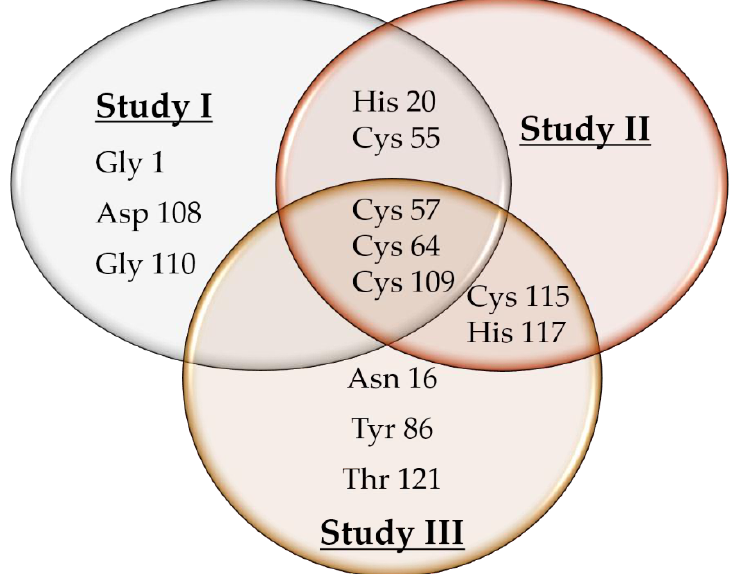
Figure 7. Venn diagram of the active site analysis of viral proteases. Study I comprises the results of recent investigation. Study II comprises the results analysis of Yu and Lloyd [13], while study III comprises the Sommergruber et al. results [58].